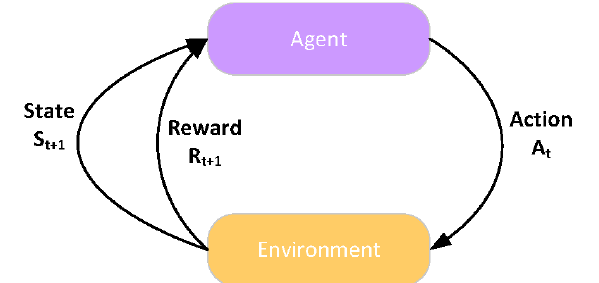
Figure 10. Learning problem explained through reinforcement